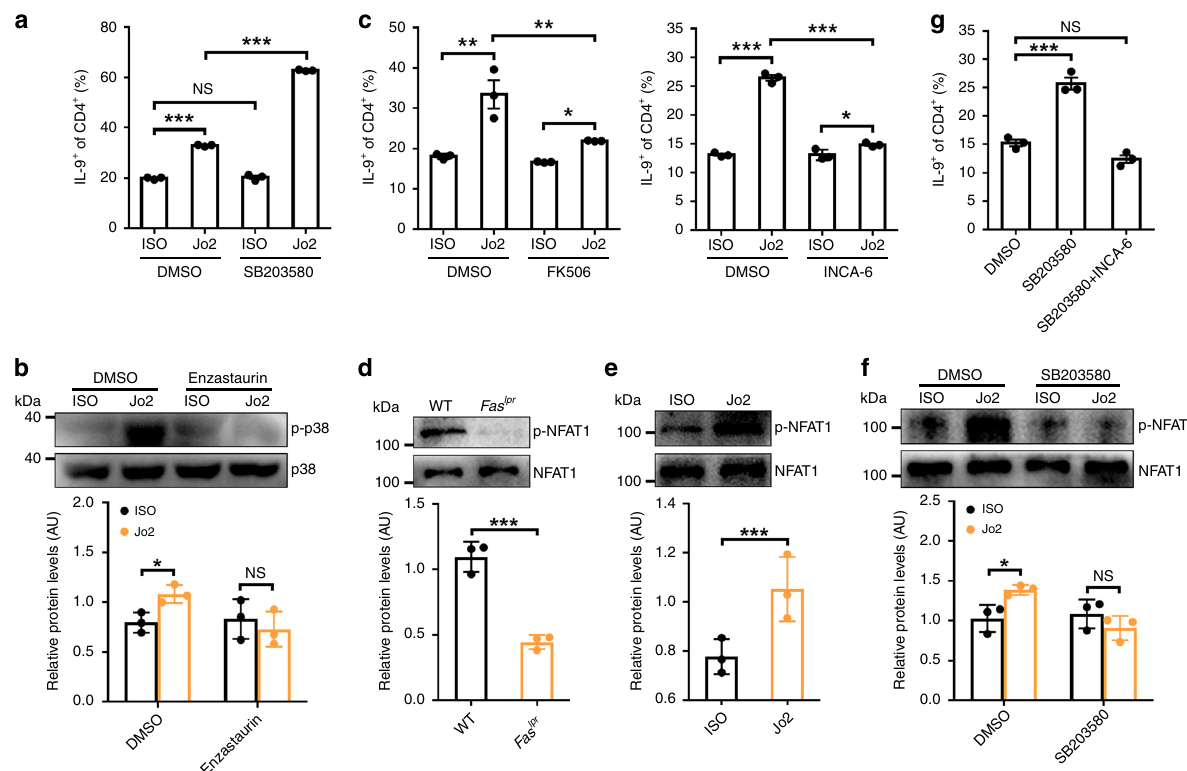
Fig. 4 p38 inhibits T helper type 9 (T H 9) cell generation by Fas signaling. a Flow cytometric analysis of IL-9 + (interleukin-9 + ) cell frequency among CD4 + T cells after naive CD4 + T cells were stimulated with 10 μ g ml − 1 ISO or Jo2 and with or without 0.4 μ M p38 inhibitor SB203580 under T H 9-skewing conditions for 4 days. b Western blotting analysis of p-p38 proteins in naive CD4 + T cells stimulated with 10 μ g ml − 1 ISO or Jo2 for 15 min and with or without 0.5 μ M enzastaurin under T H 9-skewing conditions (up), and statistical analysis of the relative protein levels (down). c Flow cytometric analysis of IL-9 + cell frequency among CD4 + T cells after naive CD4 + T cells were stimulated with 10 μ g ml − 1 ISO or Jo2 and with or without NFAT inhibitor (5 pM FK506 or 50 nM INCA-6) under T H 9-skewing conditions for 4 days. d , e Western blotting analysis of p-NFAT1 proteins in WT or Fas lpr CD4 + T cells (up) ( d ) or WT CD4 + T cells stimulated with 10 μ g ml − 1 ISO or Jo2 ( e ) under T H 9-skewing conditions for 15 min (up), and statistical analysis of the relative protein levels (down) ( d , e ). f Western blotting analysis of p-NFAT1 proteins in WT CD4 + T cells stimulated with 10 μ g ml − 1 ISO or Jo2 and with or without 0.4 μ M SB203580 under T H 9-skewing conditions for 15 min (up) and statistical analysis of the relative protein levels (down). g Flow cytometric analysis of IL-9 + cell frequency among CD4 + T cells after naive CD4 + T cells were stimulated with 10 μ g ml − 1 Jo2 in the presence of 0.4 μ M SB203580 or 50 nM INCA-6 plus 0.4 μ M SB203580 under T H 9-skewing conditions for 4 days. AU, arbitrary units; NS, not signi fi cant; * P < 0.05, ** P < 0.01, and *** P < 0.001 (unpaired Student ’ s t test ( a , c , g )). Representative results from three independent experiments are shown (mean and s.d.). Relative protein levels = the indicated protein gray values/p38 ( b ) or NFAT1 ( d – f ) gray